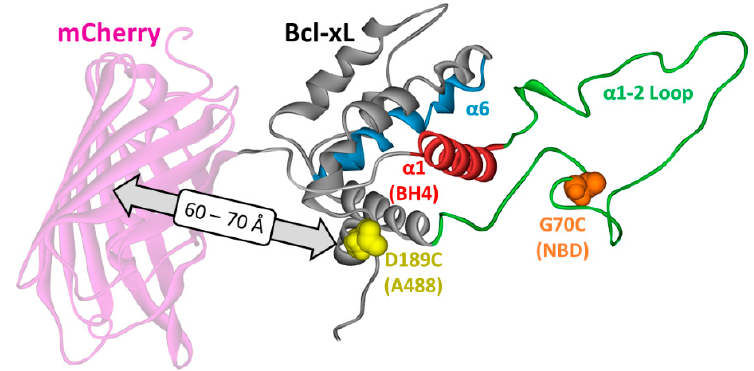
Figure 2. Bcl-xL constructs used in this study. The structure of Bcl-xL solved by NMR [14] is presented as backbone conformation in grey with the following color highlights: hydrophobic helix α 6 in blue, BH4 helix α 1 (BH4 domain) in red, the loop between α 1 and α 2 helices in green. The NBD-labeling site in single-Cys G70C mutant is shown in orange. The FRET donor Alexa-Fluor-488-labeling site in the D189C mutant is shown in yellow. The latter construct also had an N-terminally conjugated mCherry fluorescence protein (magenta), to be used as an acceptor in FRET measurements (see text for details).